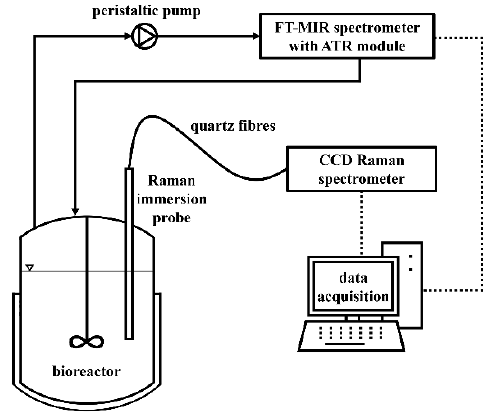
Figure 1. Measurement setup for simultaneous monitoring of yeast fermentations using Raman and mid-infrared spectroscopy.